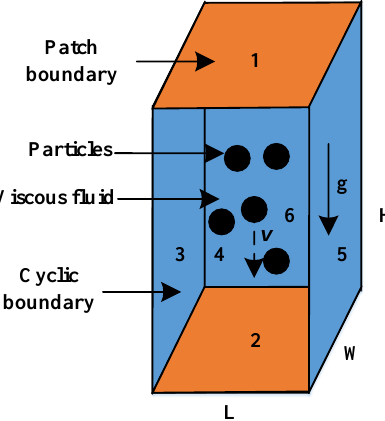
Figure 2. Numerical model on settlement of multiple particles. Table 1. Parameters of sedimentation model of multiple